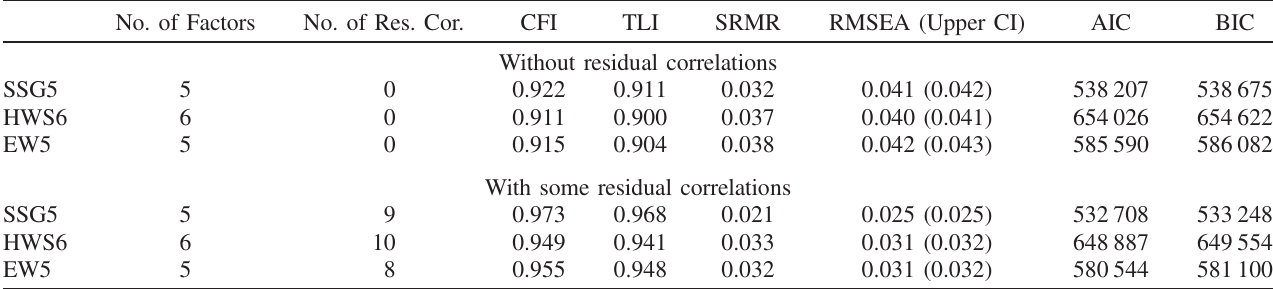
TABLE IV. Fit statistics for the three models applied to the full sample, N ¼ 20 822 , without and with residual correlations (Res. Cor. in the